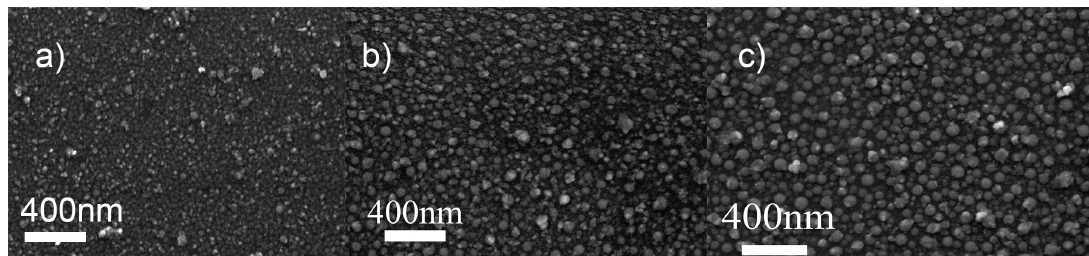
Figure 2. Scanning electron microscopy images of antimony tin oxide thin films a) as prepared, b) annealed in a nitrogen and c) Forming gas atmospheres at 425°C, respectively.